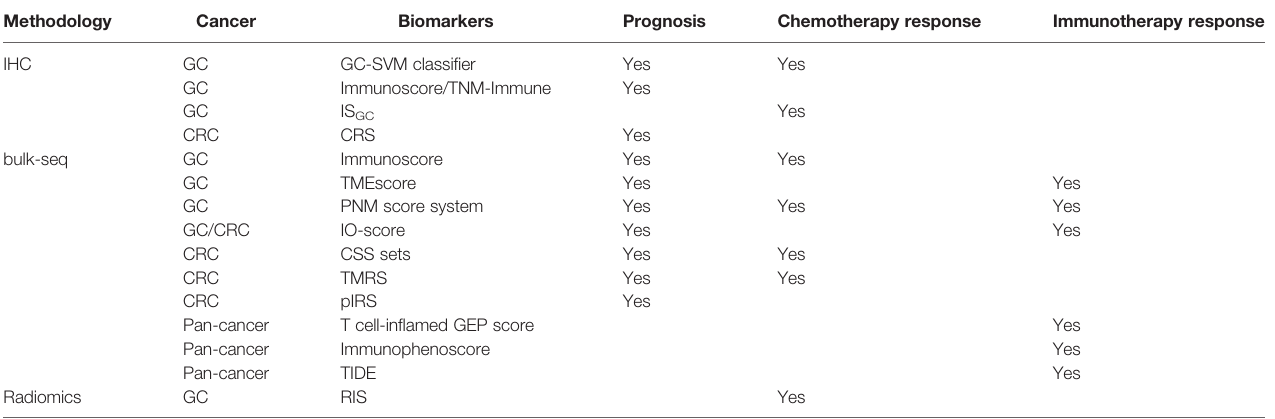
TABLE 1 | The implementation and comparison of biomarkers based on TME evaluation.